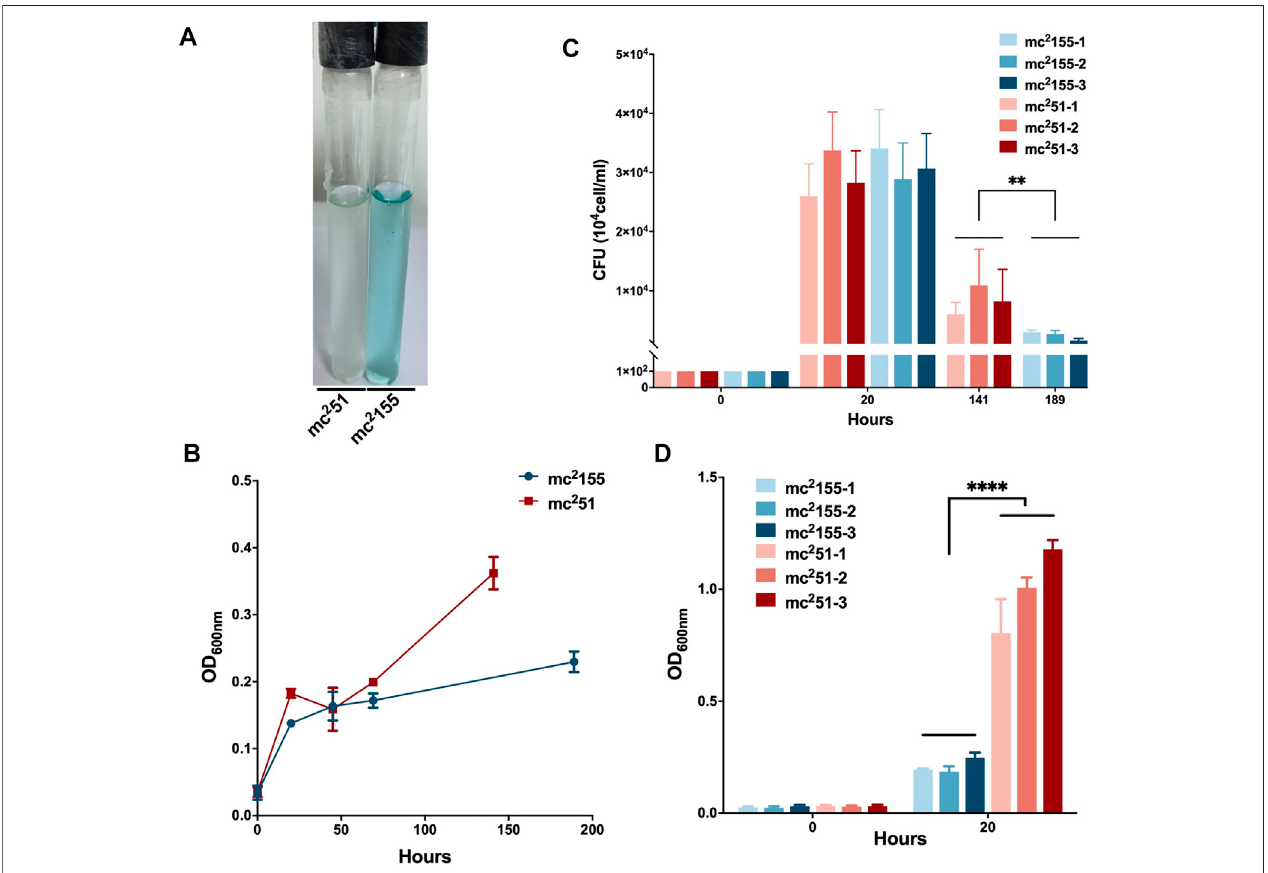
FIGURE 2 | Survival in hypoxic environments and resuscitation of M. smegmatis mc 2 155 and mc 2 51. (A) The oxygen tension indicator methylene blue of mc 2 51 culture (left) changes to colorless on day 6, while the indicator of mc 2 155 culture (right) stays blue in the Wayne dormancy model. The cultures were initially inoculated in anaerobic tubes at an OD 600 of 0.01 with a headspace ratio of 0.5. The cultures were stirred at 120 rpm. Methylene blue (1.5 mg/L) was used as an oxygen tension indicator. Methylene blue changes from blue to colorless under reducing conditions. Data present results of three biological replicates. Growth rates of strains mc 2 155 (navy blue) and mc 2 51 (brown) were measured by measuring the OD 600 (B) and by determination of CFUs (C) after plating on 7H10. Data are presented as the mean ± standard deviation of three independent replicates. ** p < 0.01. (D) The H 2 O 2 -resistant mutant strain mc 2 51 shows a growth advantage of recovering from dormancyinananaerobicstateovermc 2 155.AftertheindicatormethyleneblueinthecultureoftheWaynedormancymodelbecamecolorless,culturesofmc 2 155(navy blue) or mc 2 51 (brown) were collected and reinoculated into 7H9 combined with the heart infusion medium at an OD 600 of 0.01 and aerobic shaken at 200 rpm. The CFUs were determined 20 h after inoculation. Data are presented as the mean ± standard deviation of three independent replicates. **** p <